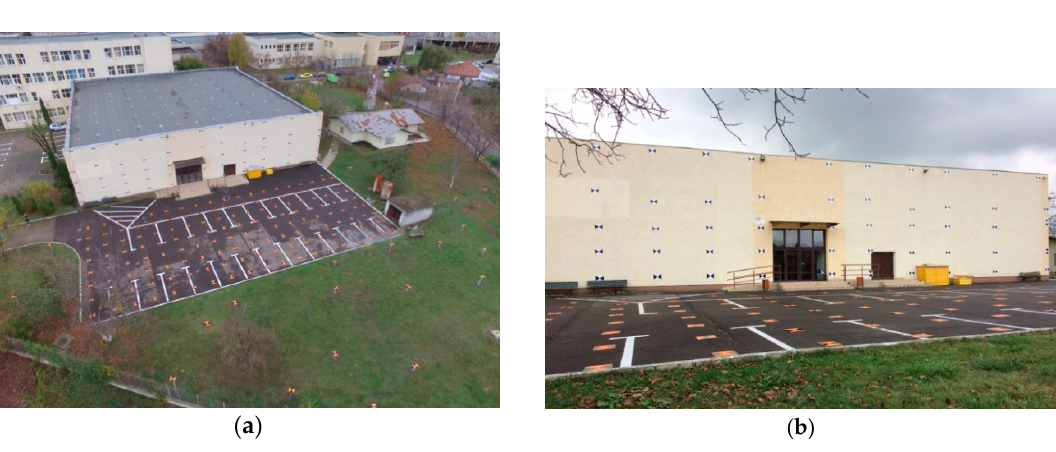
Figure 2. ( a ) UAS image over the 3D calibration field of digital non-metric cameras mounted on Unmanned Aerial Systems, ( b ) ground image.